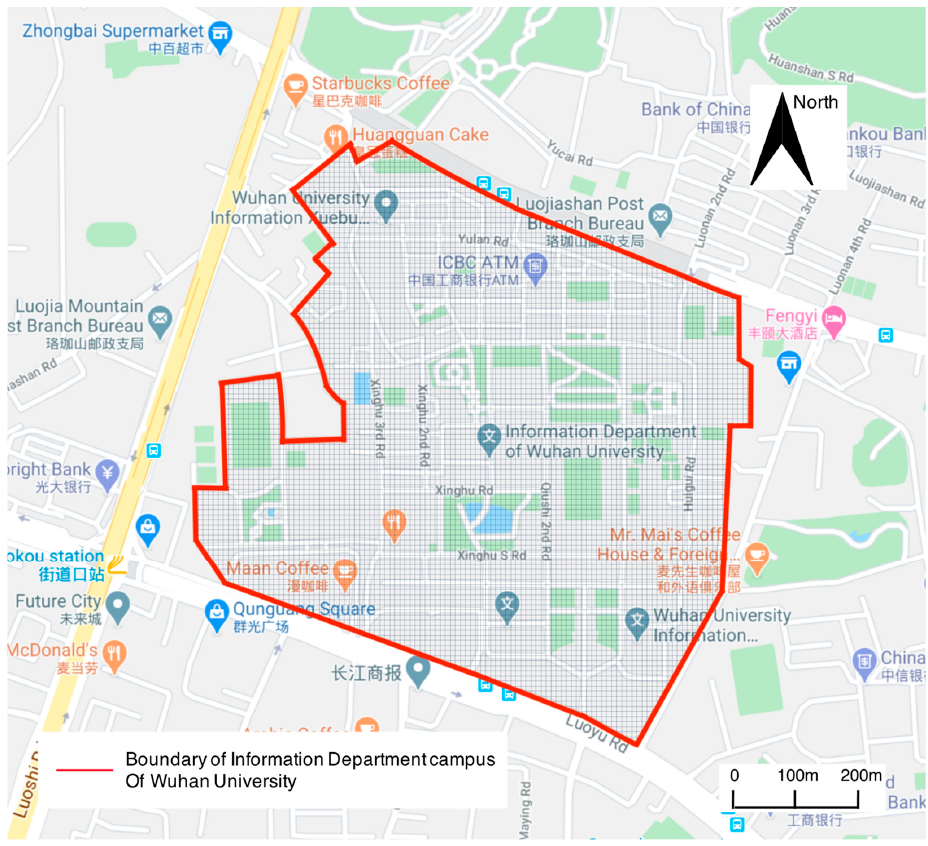
Figure 1. The location of the Information Department Campus of Wuhan University. The source of the map is Google Maps. the map is Google